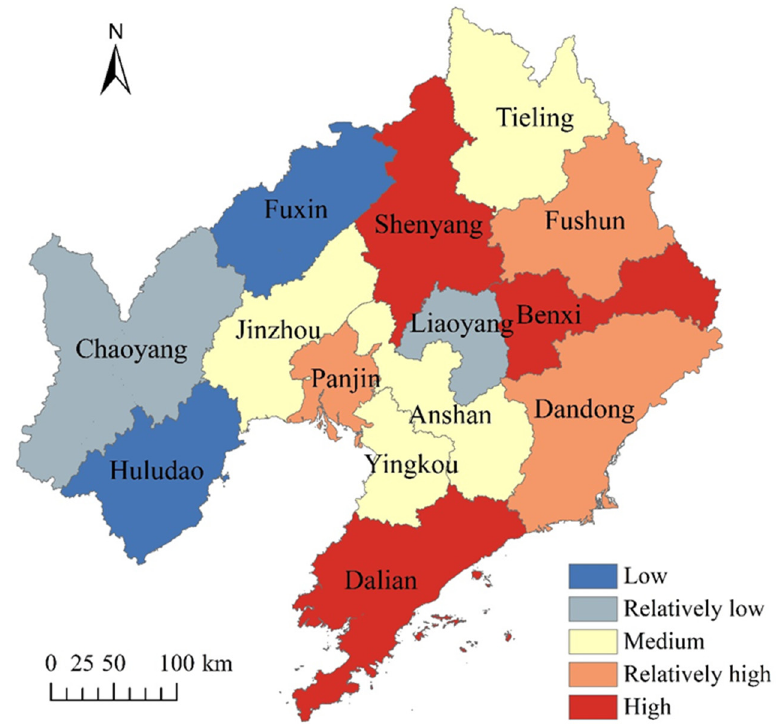
Figure 5. Spatial distribution pattern of LCCC in Liaoning Province.